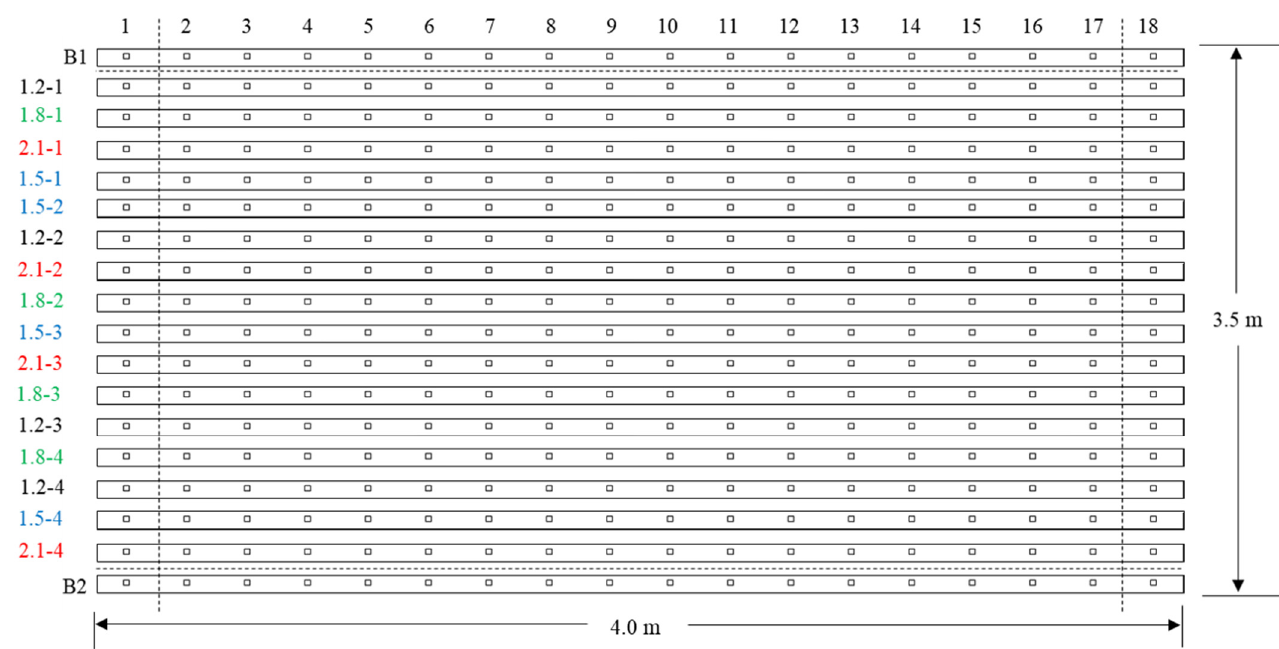
Figure 1. Growing channel layout showing the location of treatments replications. The air temperature and air humidity of the greenhouse were measured every 10 s with a humidity and temperature probe (INTERCAP ® HMP50; Vaisala, Helsinki, Fin- land). Photosynthetic photon flux density (PPFD) was provided by natural light and high-intensity discharge (HID) lamps (400-Watt high-pressure sodium (HPS), Energy Technics Horticulture Lighting, York, PA, USA) for 16 h per day and measured every 10 s with a sun calibration quantum sensor (SQ-110-SS; Apogee Instruments, Logan, UT, USA). Air temperature, air humidity and average light intensity were logged every 10 s with a micrologger (CR3000; Campbell Scientific, Logan, UT, USA). During the experiment, the average ( ± standard error) day and night air temperature, air humidity and daily light integral of PPFD were 18.51 ± 0.05 ◦ C, 16.76 ± 0.02 ◦ C, 50.85 ± 0.14 % and 17.03 ± 1.71 mol · m − 2 · d − 1 , respectively. lected Seeds, Albion, ME, USA) as the model plant. A water-soluble fertilizer (Hydro Grow Leafy Green Fertilizer; 4.3% N-9.3% P-35% K: Crop King, Lodi, OH, USA) at 100 mL · L − 1 and calcium nitrate (CropKing) at 78 mL · L − 1 was used as fertilizer stock solution which were used to prepare feeding solutions with four different EC treatments in the